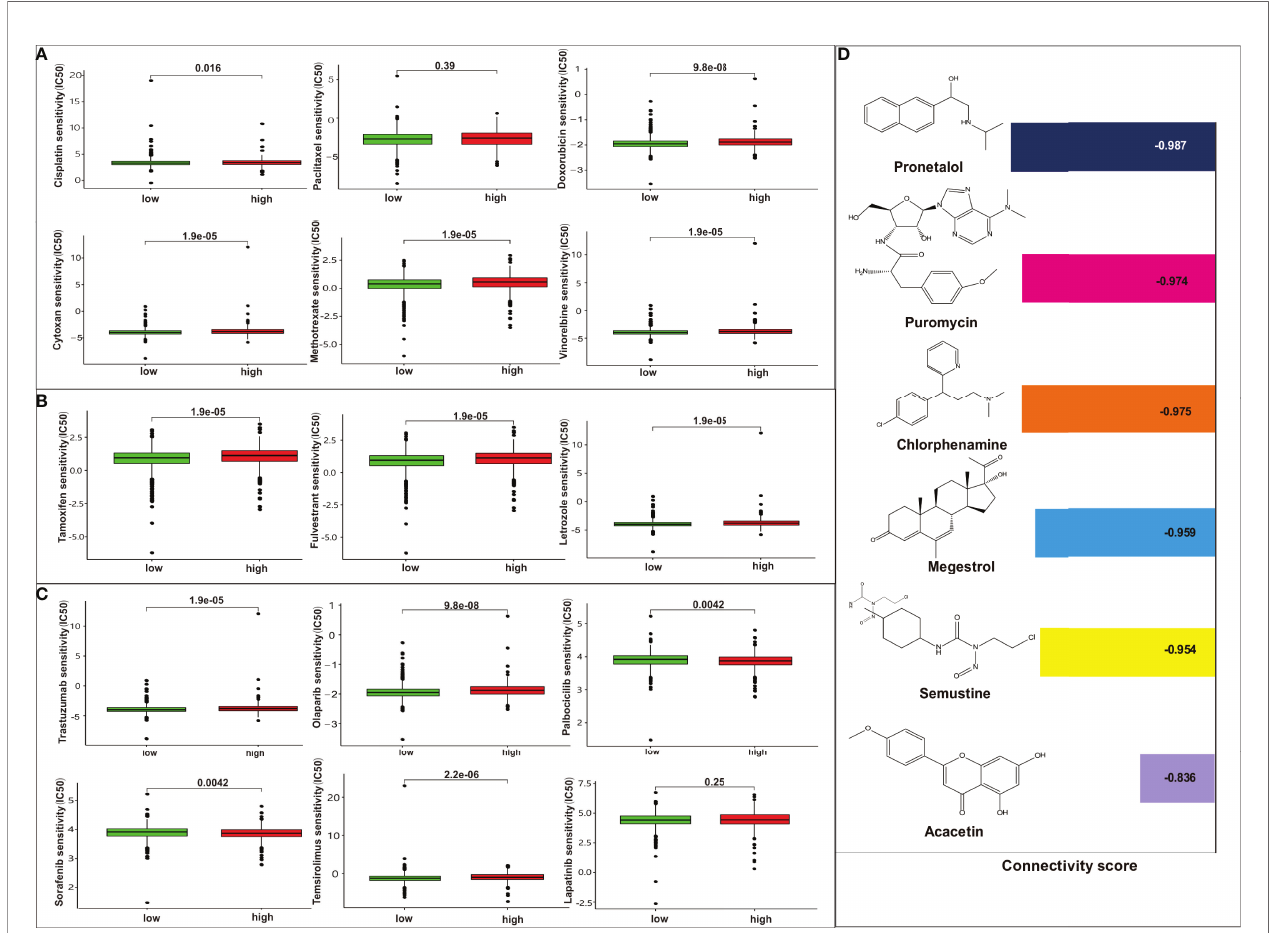
FIGURE 6 | Analysis of the association between the risk model and chemotherapeutics, endocrine therapy, and targeted therapy. (A) The model predicting the sensitivity to chemosensitivity. It was estimated that low-risk patients had lower IC 50 for chemotherapeutics such as paclitaxel, cisplatin, and doxorubicin, cytoxan, methotrexate, vinorelbine, except for paclitaxel; (B) The model predicting the sensitivity to endocrine therapy. It was estimated that low-risk patients had lower IC 50 such as tamoxifen, fulvestrant, and letrozole. (C) The model predicting the sensitivity to targeted therapy. It was estimated that low-risk patients had lower IC 50 such as trastuzumab, olaparib, temsirolimus, whereas high-risk patients had lower IC 50 for targeted therapy such as palbociclib, sorafenib. There are no differences between high risk or low risk patient for lapatinib; (D) CMap analysis for high-risk score patients. Six targeted drugs such as pronetalol, puromycin, chlorphenamine, megestrol, semustine, and acacetin are predicted therapy for this risk score in breast